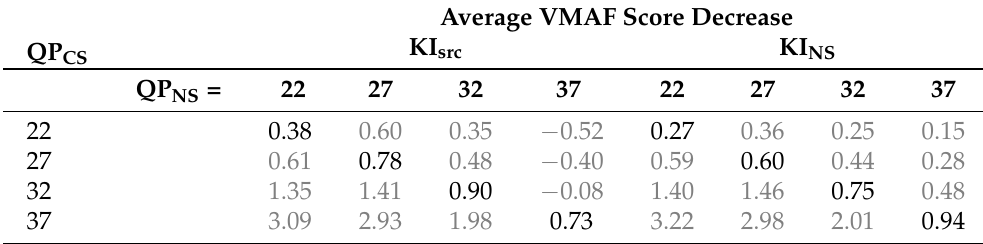
Table 2. Average decrease in VMAF